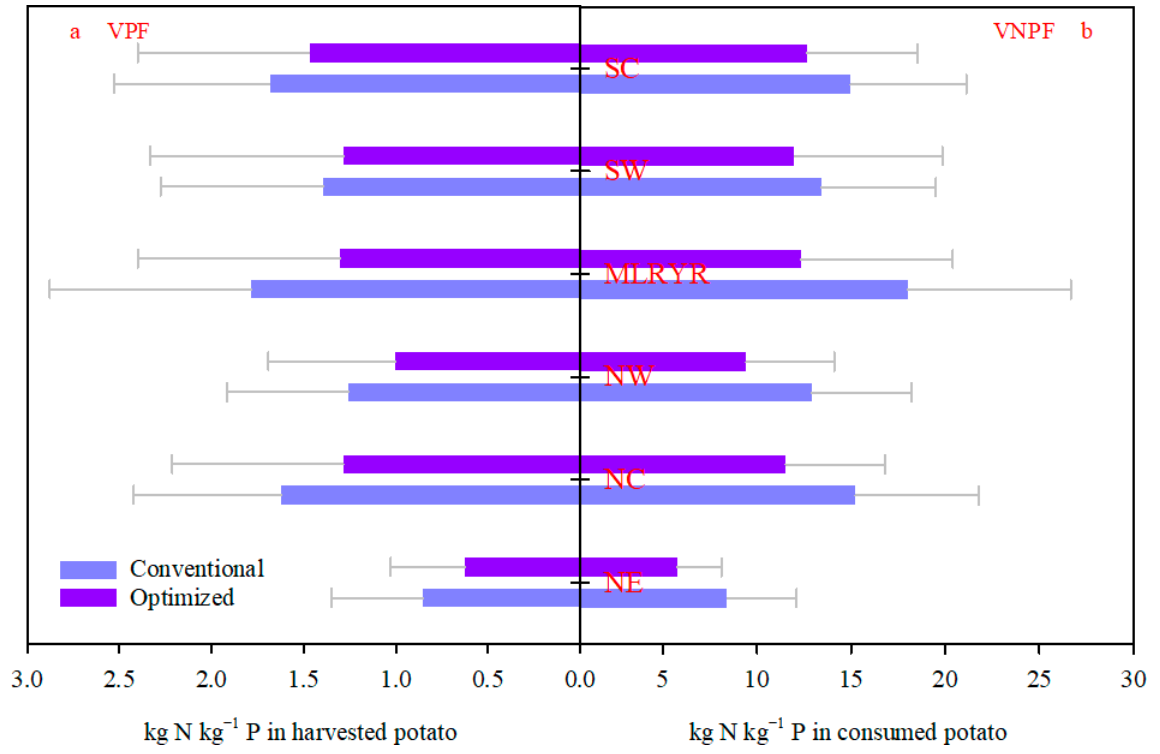
Figure 3. VPF ( a ) and VNPF ( b ) indicators of potatoes under conventional and optimized measures in the six cultivation